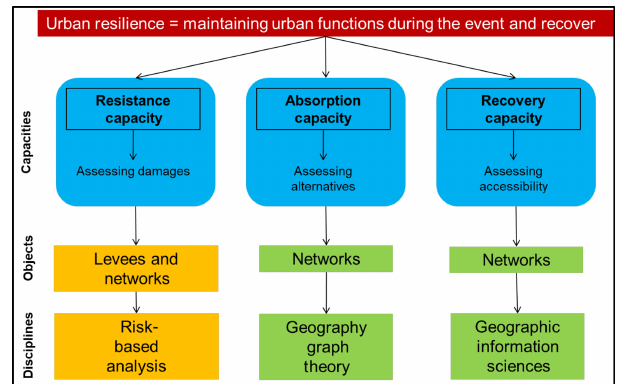
Figure 2. DS3 Model (taken from Serre, 2016).